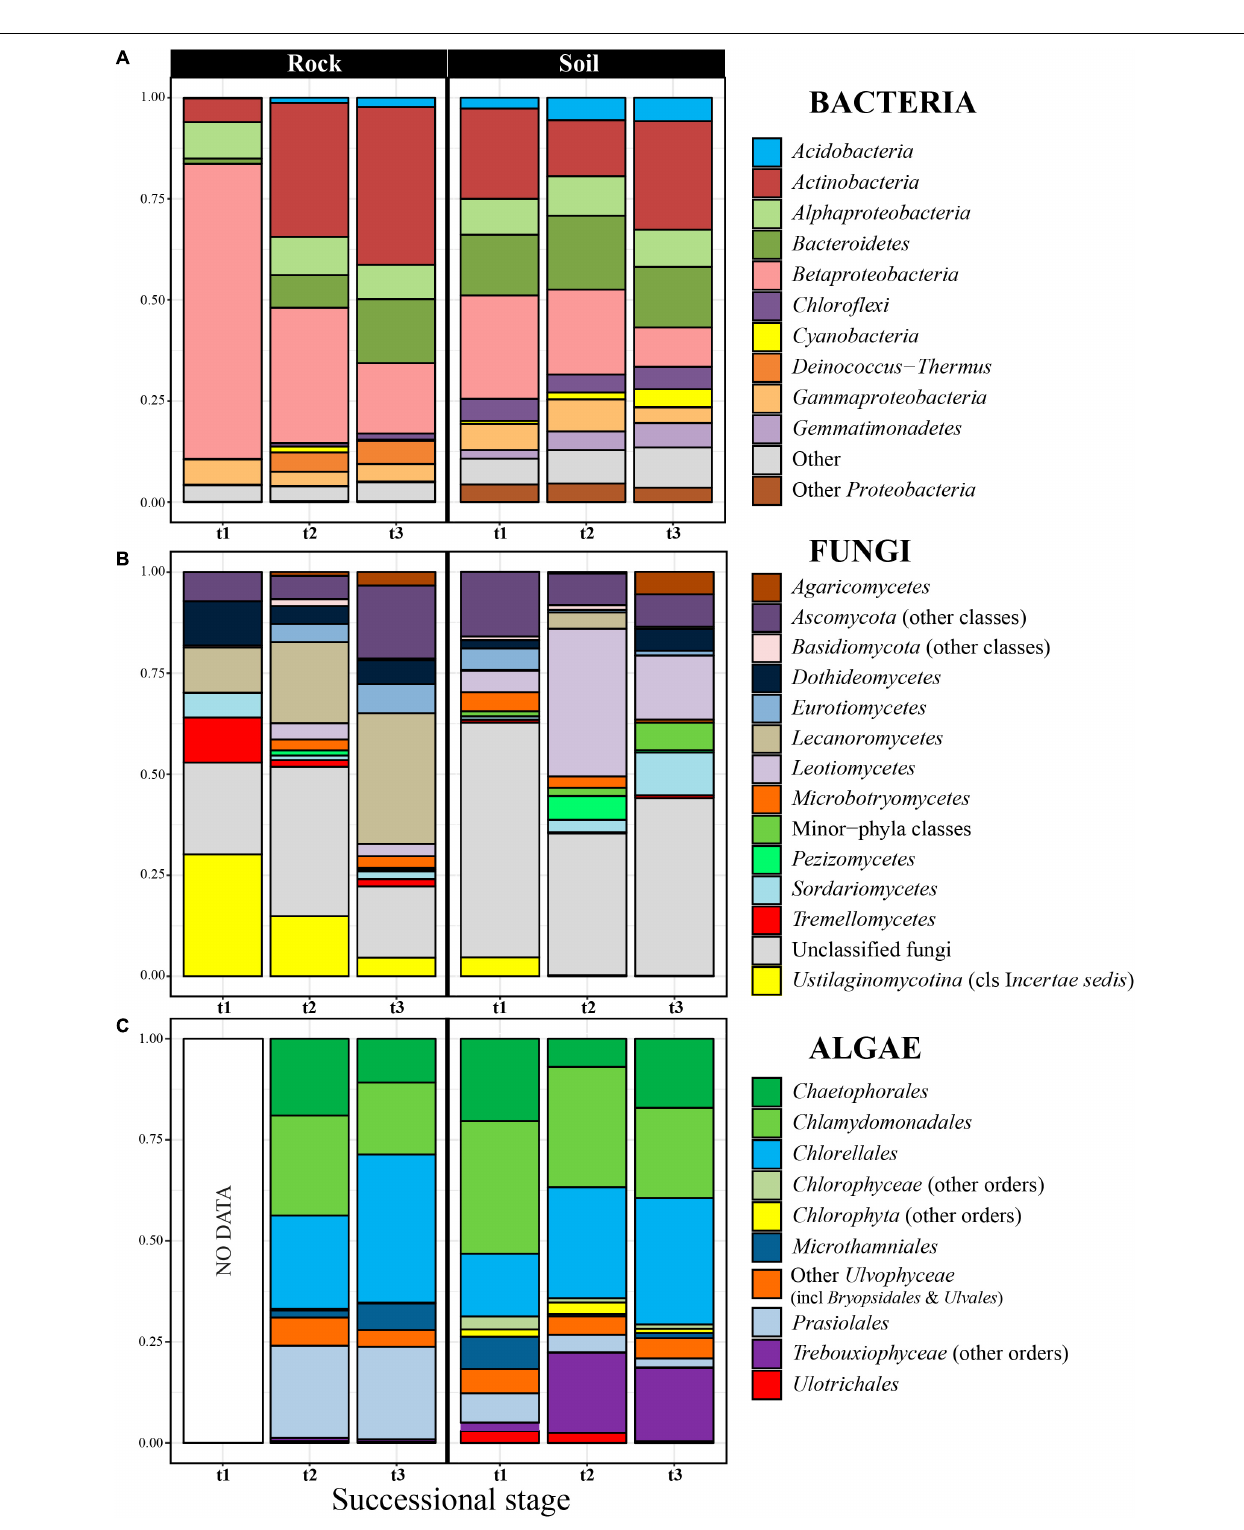
Frontiers in Microbiology |